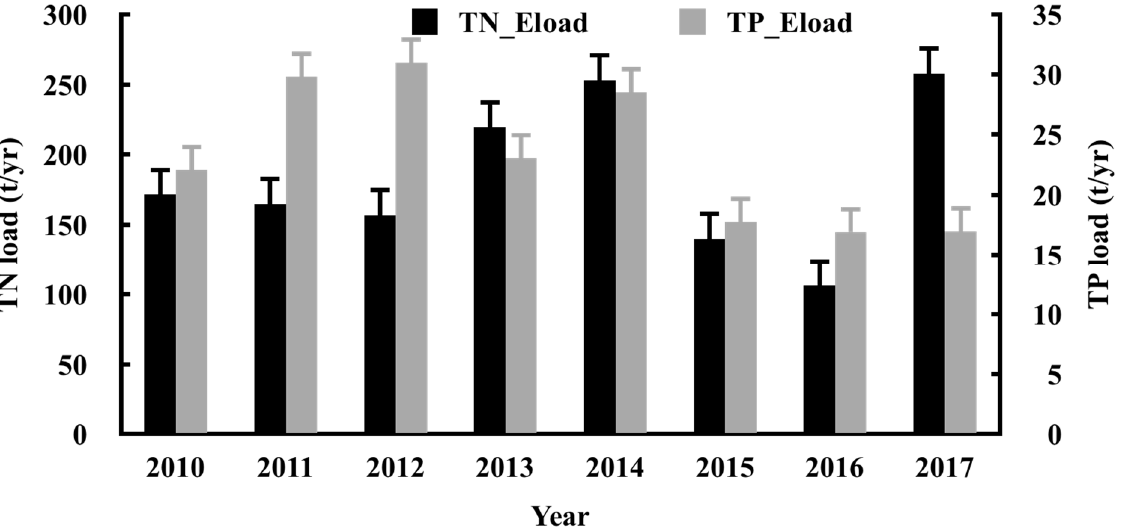
Figure 6. Annual tributary external loadings of TN (TN_Eload) with positive standard errors (black, left Y axis), and TP (TP_Eload) with positive standard errors (grey, right Y axis), in Lake Xingyun